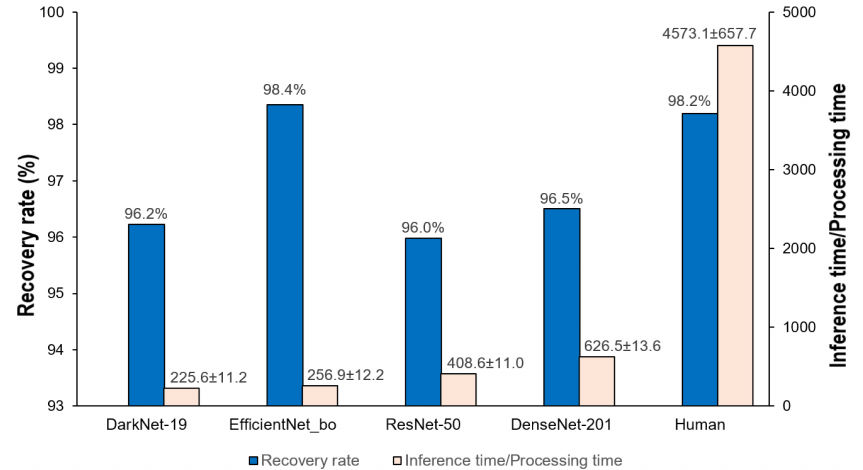
Figure 11, the EfficientNet-B0 correctly recognized all four serial number images (checksum result = 0).